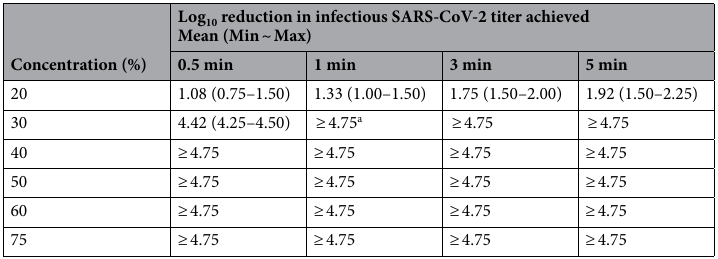
Table 6. Effect of ethanol on SARS-CoV-2 inactivation. a The value of ≥ 4.75 means that no live virus is observed after the treatment, while the smaller values indicate that a different virus survives after the treatment.